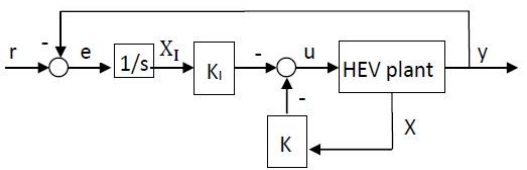
Figure 4. Block diagram for the HEV longitudinal speed control with robust feedback controller.